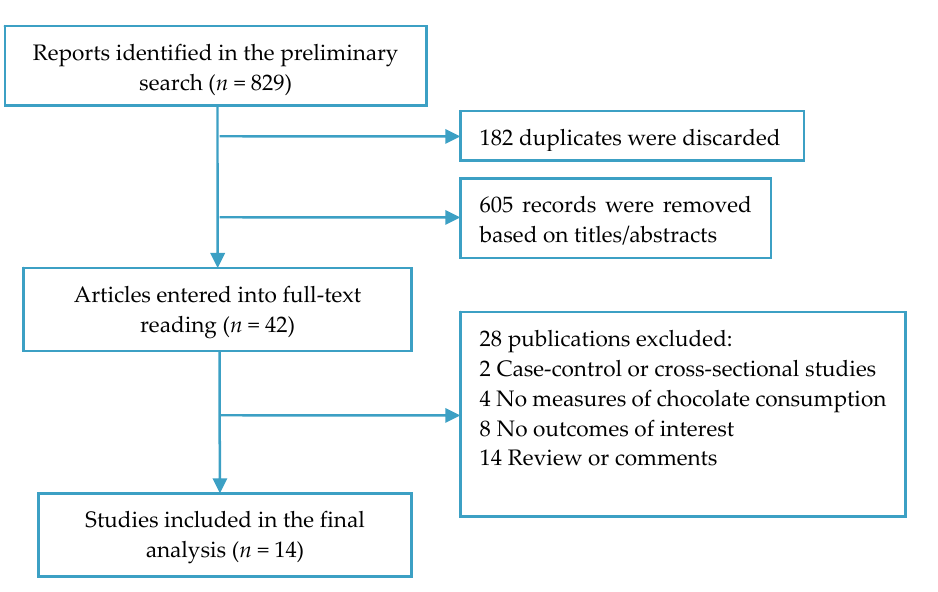
Figure 1. Flow diagram of study selection.